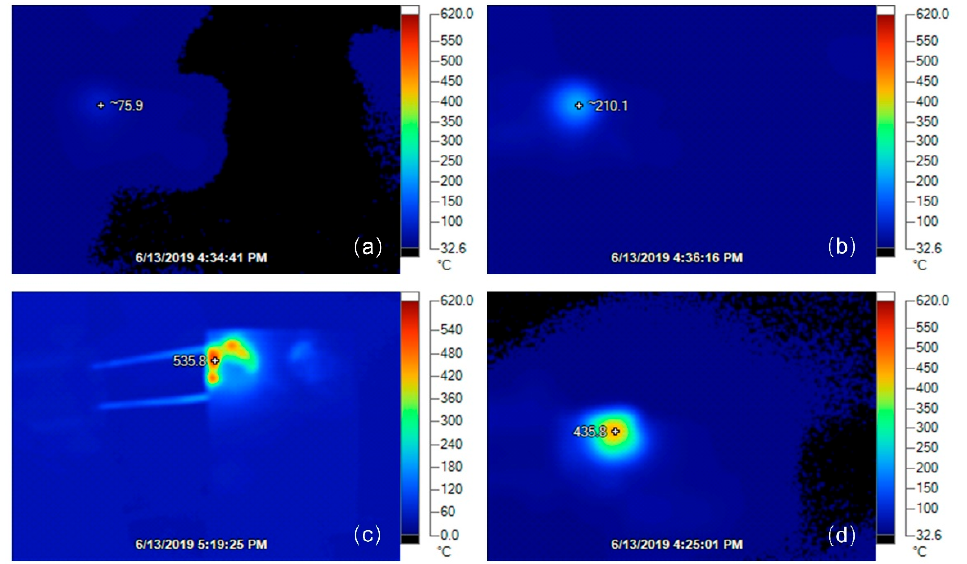
Figure 4. Temperature distribution during the induction heating of AISI 1008 steel using an: ( a ) Induction coil at d = 10mm from the under-treatment surface, during heating for t (cid:2925) = 3s ; ( b ) induction coil at d = 10mm from the under-treatment surface, one minute after heating for t (cid:2925) = 3s ; ( c ) induction coil at d = 0.2mm from the under-treatment surface, one minute after heating for t (cid:2925) = 3s ; ( d ) the V-shaped or U-shaped conductor at d = 0.2mm from the under-treatment surface, one minute after heating for t (cid:2925) = 3s .